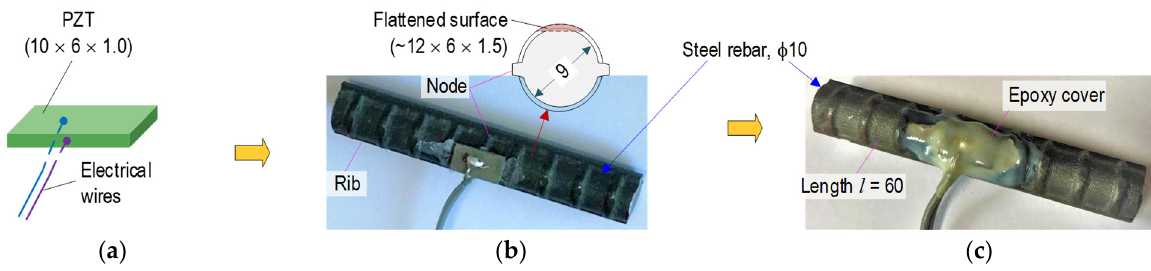
Figure 6. Prototype of PZT-embedded rebar for impedance monitoring (unit in mm): ( a ) PZT patch; ( b ) PZT mounted on steel rebar, ( c ) Smart rebar.